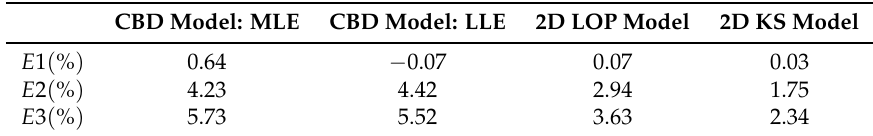
Fitting results for GB male mortality data from 1950–2016, ages 50–89. CBD, Cairns–Blake–Dowd; LOP, Legendre orthogonal polynomial; KS, kernel smoothing. CBD Model: MLE CBD Model: LLE 2D LOP